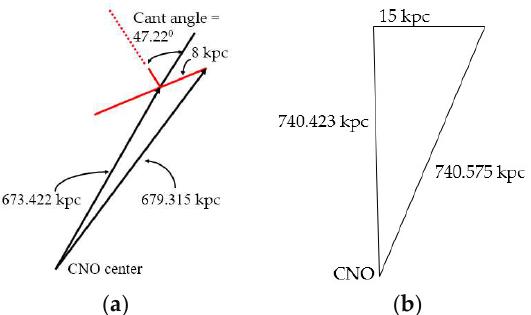
Figure 8. The geometry for the CNO’s center to distances from the center of the galaxies was used for computing the density differences for: ( a ) the canted Milky Way’s center to 8 kilo parsecs out from the center using the law of cosines; ( b ) the simpler geometry for M31 from the center to 15 kilo parsecs out with no cant angle. Table 8. Local Group Approximate Rotational Speed Values from the Galactic Center. Local Group Local